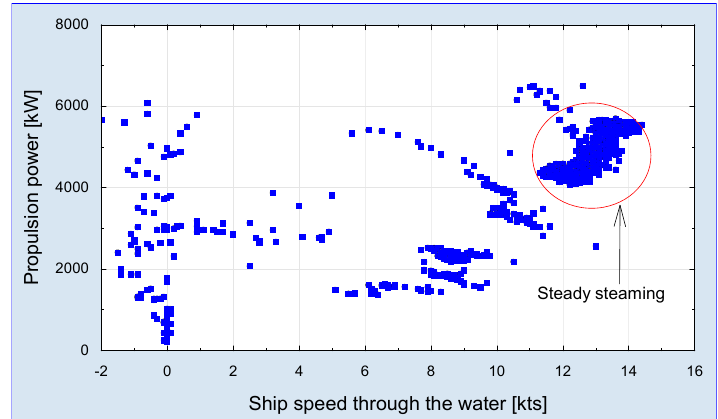
Figure 13. Ship propulsion load operational spectra during a single voyage.